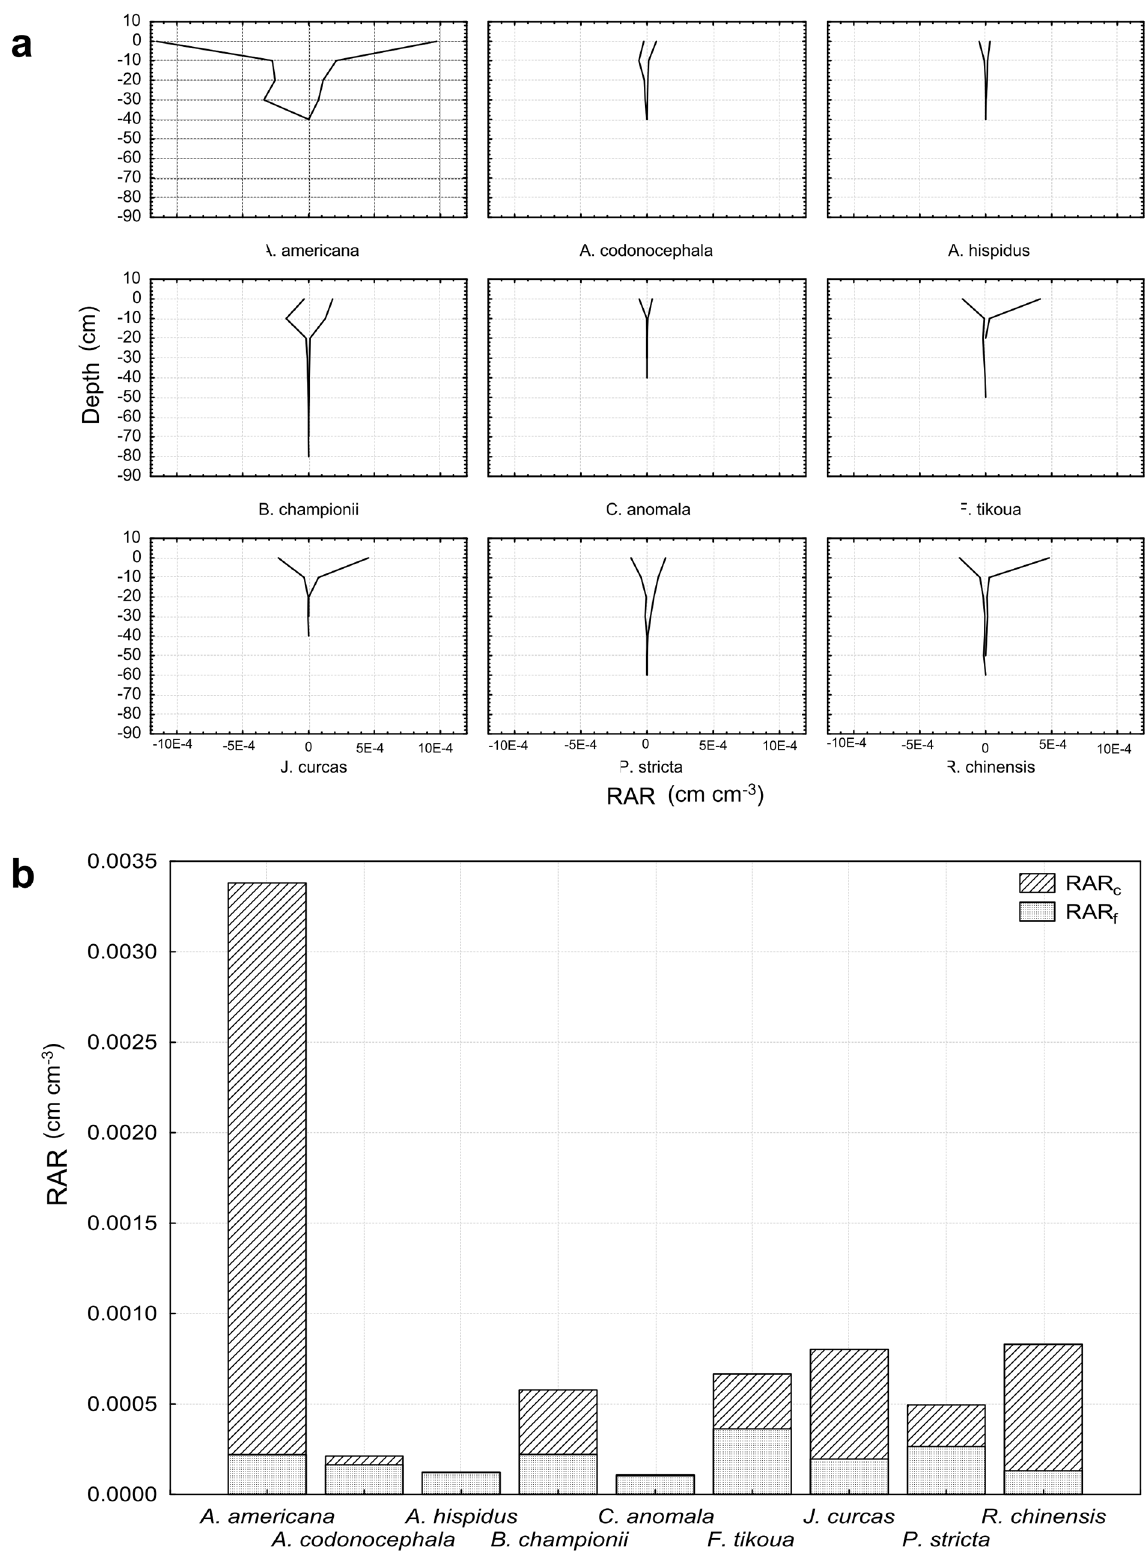
Figure 6. Root density of all species and proportion of coarse and fine roots. (a) Root area ratio (RAR) of all species. Negative values of RAR represent downslope orientation; (b) Coarse and fine roots area ratio (RAR).